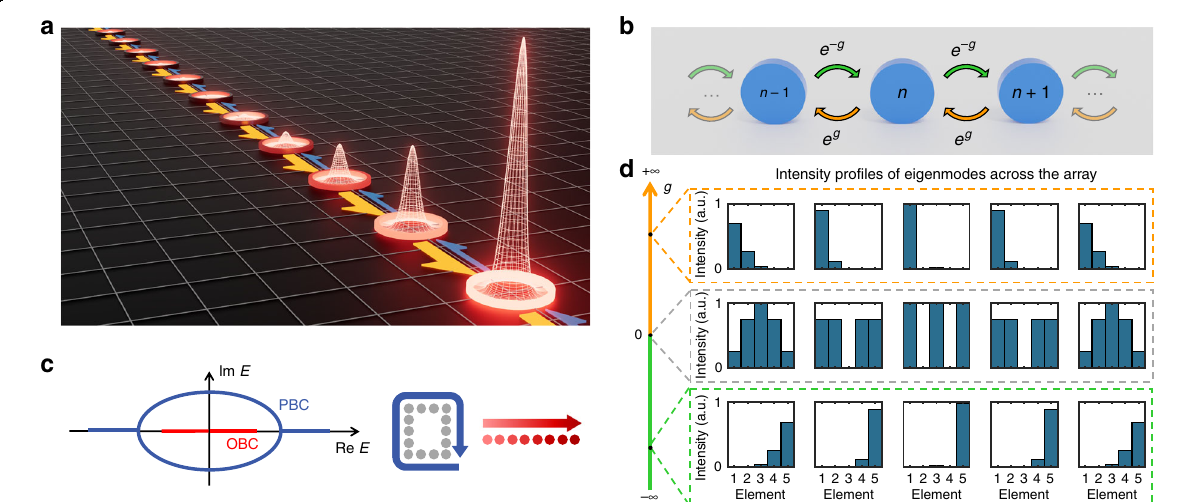
Fig. 1 Hatano – Nelson model. a A schematic of a 1D Hatano-Nelson lattice. The non-Hermitian skin effect localizes the intensity at the edge of the lattice. b A generalized Hatano – Nelson lattice with asymmetric coupling marked by orange and green arrows. c Eigen-energies of a Hatano – Nelson lattice when periodic boundary condition (PBC) or open boundary condition (OBC) is applied. d Non-Hermitian skin effect appears when the coupling is asymmetric (orange and green sections) thus the energy distribution in the modes tilts towards left and right ends,